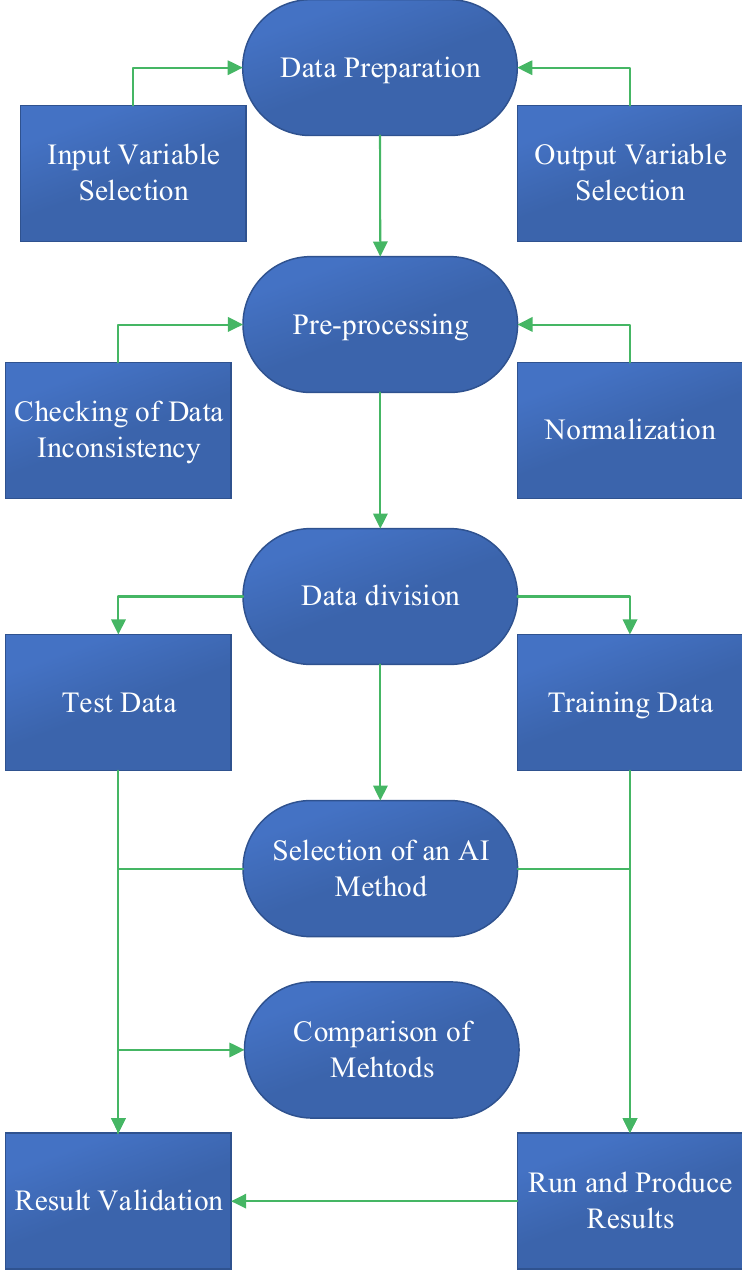
Figure 2. Steps in building an AI-based RFFA model.